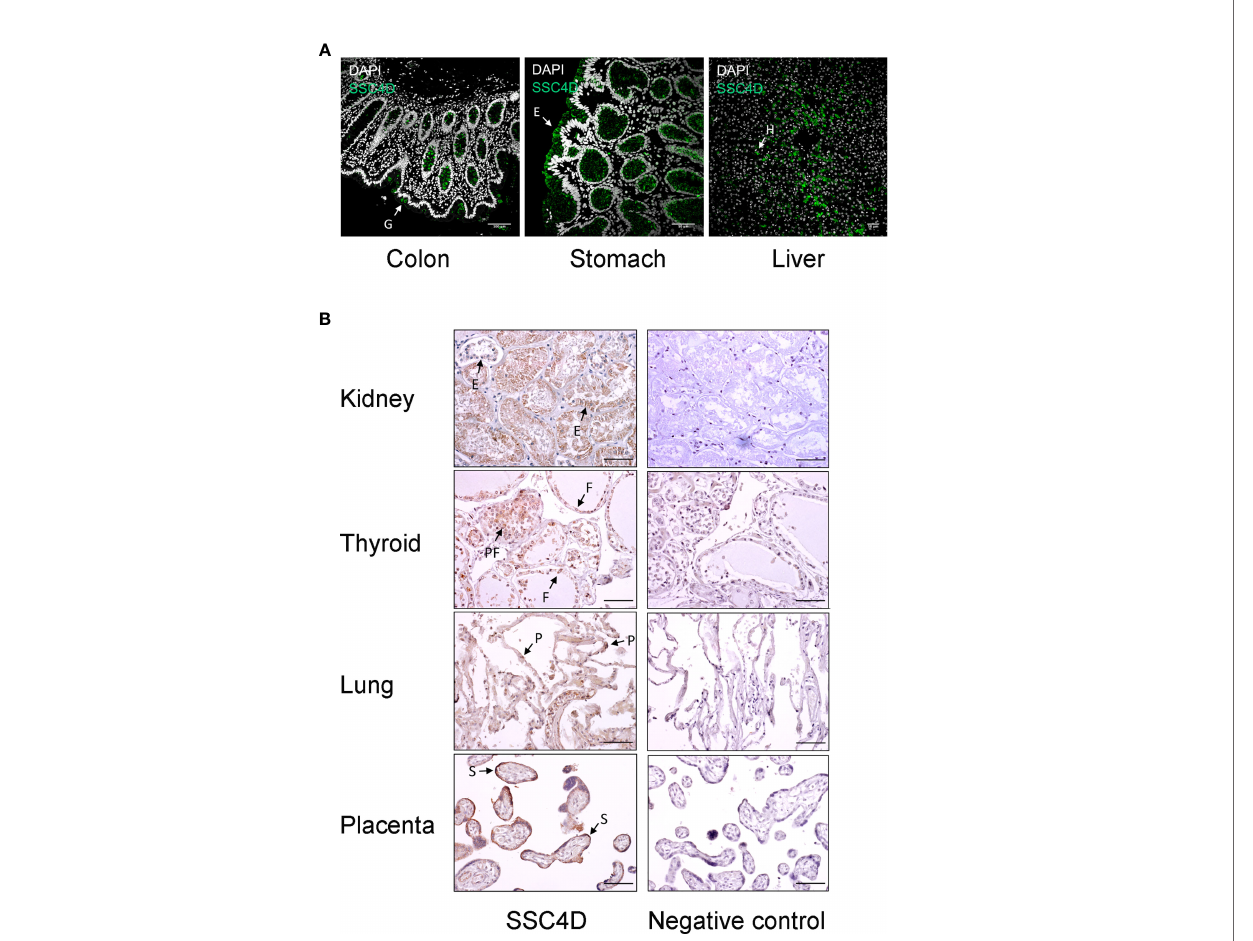
FIGURE 2 | SSC4D distribution in human organs. (A) Detection of SSC4D by immuno fl uorescence (IF) in sections of the colon, stomach, and liver from normal human subjects. SSC4D labeling in mucous goblet cells (G) in the colon, simple columnar epithelium cells (E) in the stomach, and hepatocytes (H) in hepatic lobules is shown by arrows. Cell nuclei were stained with 4 ′ ,6-diamidino-2-phenylindole (DAPI; white). No unspeci fi c staining was seen following incubation with secondary antibody alone, con fi rming speci fi city of the primary antibody. Scale bar, 50 m m. (B) Immunohistochemical analysis of SSC4D expression in sections of the kidney, thyroid, lung, and placenta. On the left column, SSC4D labeling was visualized by horseradish peroxidase (HRP) and substrate chromogen 3, 3'-diaminobenzidine (DAB). Positive staining of tubular epithelial cells (E) in the kidney, follicular (F) and parafollicular cells (PF) in the thyroid, pneumocytes (P) of the alveolar ducts, and of syncytiotrophoblasts (S) in the placenta is indicated by arrows. On the right column, images of sections labeled with unspeci fi c mouse IgG mAb (negative control, sc- 2025). Scale bar, 50 m m. Immunohistochemistry (IHC) and IF experiments were performed multiple times using samples from at least three